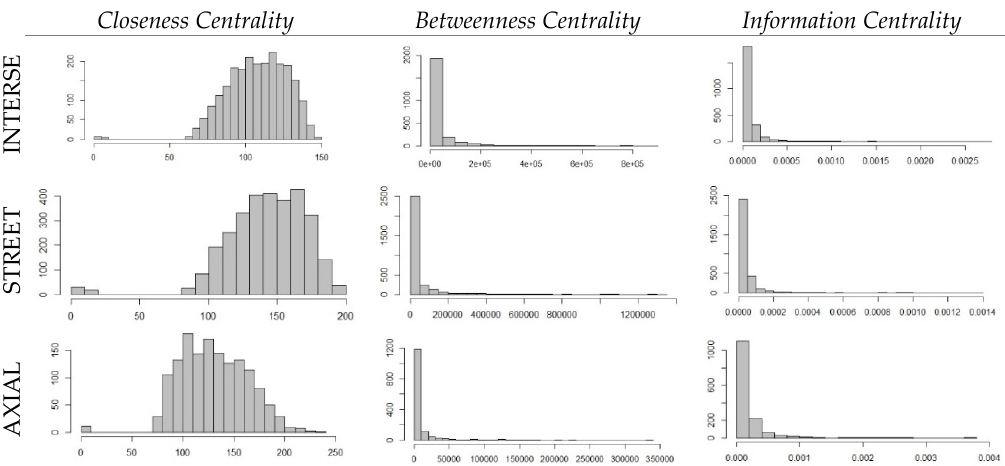
Figure 6. Histograms showing the statistical distribution of the centralities measures. Source: Authors, July 2018.